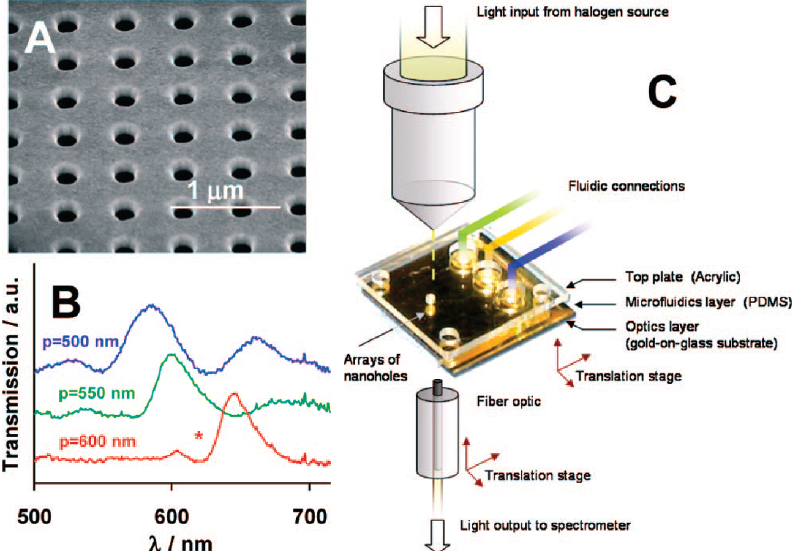
Figure 3. ( A ) Scanning electron micrograph (SEM) of an array of nanoholes in a gold film; ( B ) Extraordinary Optical Transmission (EOT) spectra for three arrays with different periodicities; ( C ) experimental setup to measure the EOT effect. The metal film is deposited on a glass slide, and the gold side of the array is exposed to solvents and aqueous solutions delivered by microfluidics. Adapted with permission from Gordon et al. [19] Copyright © 2008 American Chemical Society.